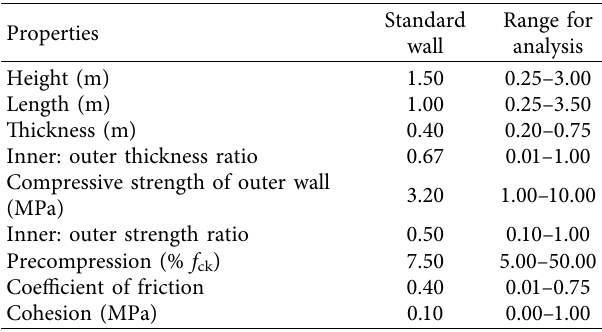
Table 2: Parameter of “Standard Wall” and range used for